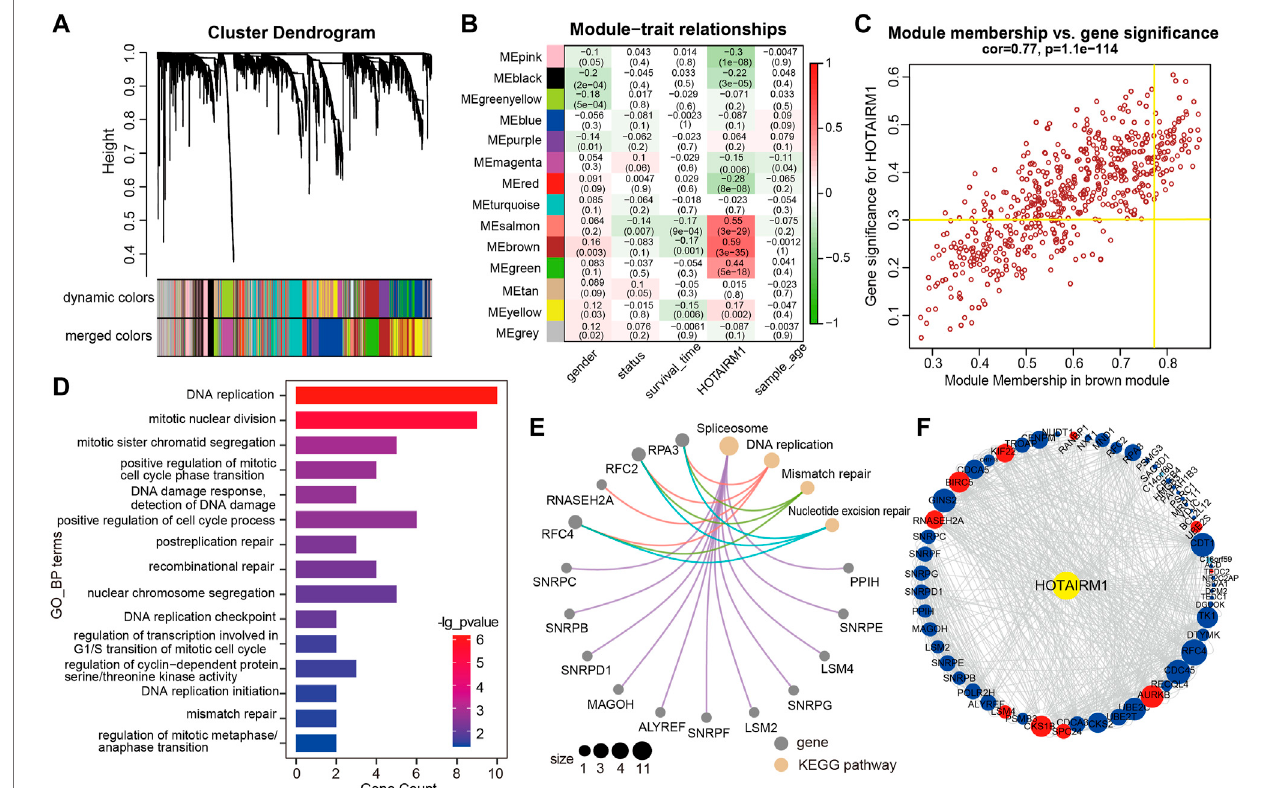
FIGURE 4 | WGCNA module analysis showing that HOTAIRM1 was mainly involved in the biological process of cell proliferation. (A) A total of 14 related modules wereidenti fi edthroughWGCNA,representedbydifferentcolors,whichweredisplayedinahierarchicalclusteringtreediagram. (B) Theheatmapshowedthecorrelation between HOTAIRM1 expression and the modular eigengenes. The brown module showed the most positive signi fi cant correlation with HOTAIRM1. (C) Scatter plot of moduleeigengenesinthebrownmodule.Thegenesmeetingthemodulecriteria, p -value ≥ 0.3andinthetop10%ofthebrownmodule,areidenti fi edaskeydriving genes associated with high HOTAIRM1 expression. (D) Functional enrichment analysis by GO demonstrated that key driver genes related to HOTAIRM1 were enriched in cell proliferation processe. (E) The KEGG signaling pathway analysis showing driver genes related to HOTAIRM1 expression enriched in the pathways regulating cell proliferation. (F) The interrelationship between the driver genes illustrated in the PPI